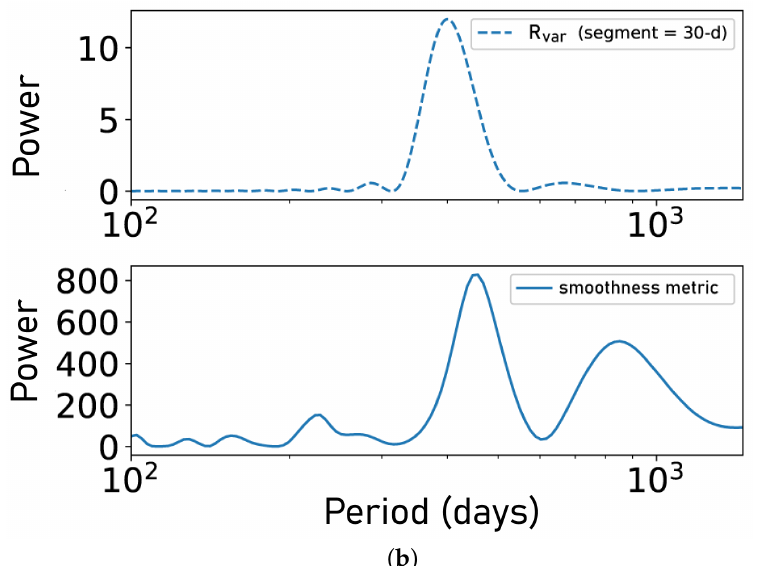
Figure 19. Panel ( a ) is the comparison between the 30 days segment R var of KIC 9017220 and the residuals of outliers as measured using our smoothness metric on KIC 9017220 (same as the right panel of Figure 3). Panel ( b ) is the power spectrum of them (these results are also shown in the left panel of Figure 4). The R var method does not pass our p -value test. Our smoothness metric passes our p -value test for KIC 9017220, and the p -value of our smoothness metric is shown in Figure